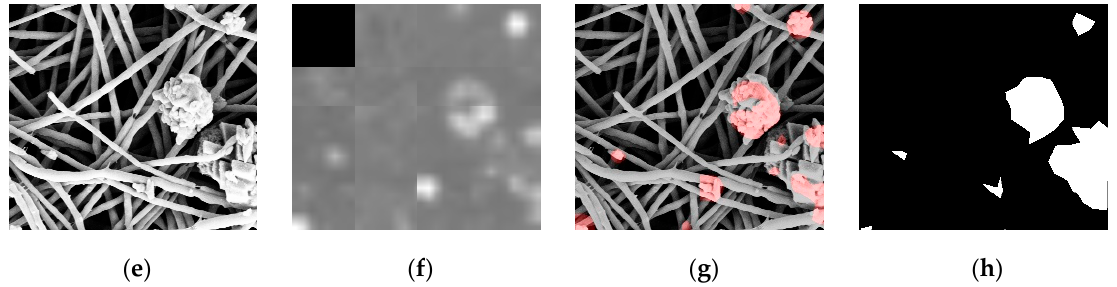
Figure 7. Nano fiber dataset network prediction result: ( a , e ) original image; ( b , f ) prediction result by segmenting the map with the sliding window; ( c , g ) network prediction confidence map, which is obtained by segmenting Figure ( b ) and ( f ) through a binary process; the red pixels are the defect areas determined on the network; ( d , h ) defect annotation map. Table 3. Network architecture defect detection results modified based on ResNet-50.